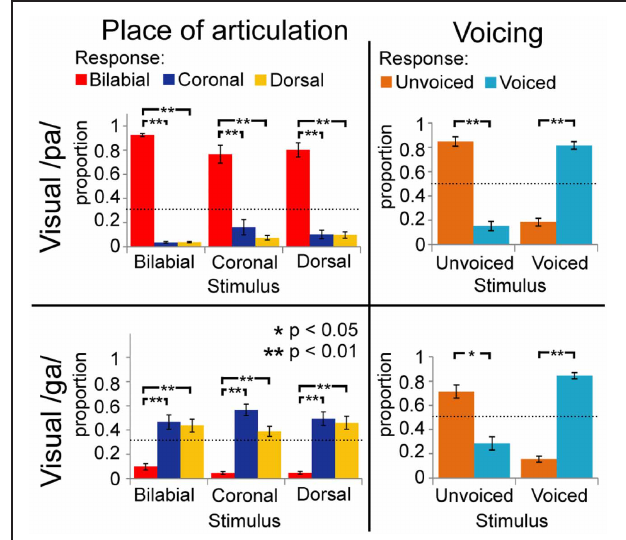
FIGURE 3 | Results of multimodal analyses for visual /pa/ and /ga/ separately collapsed over stimulus onset asynchronies (SOAs). Horizontal axis represents the category of the stimulus and vertical axis represents the response proportions of the respective categories. Dashed lines indicate chance level of responding. Voicing (VC) is dissociable, but place of articulation (POA) responses depended on the unimodal visual response in Figure 2